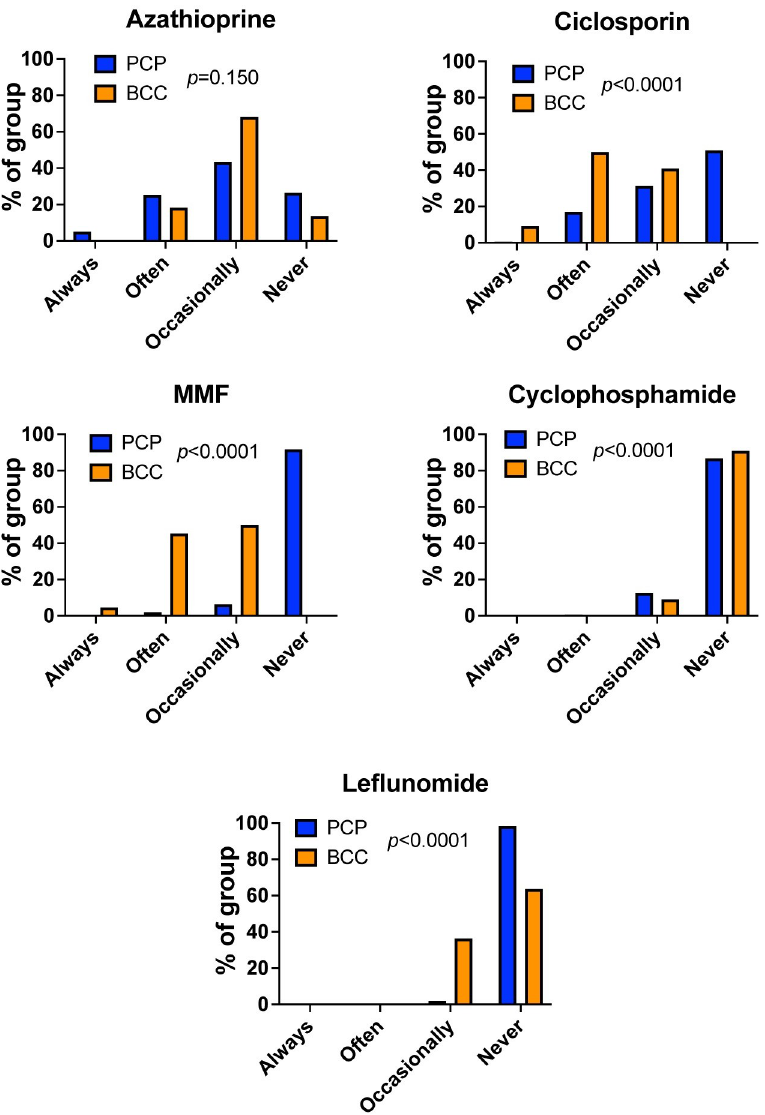
Fig 8. Primary care practitioners and board-certified clinicians use different combinations of immunosuppressive drugs in the clinic. Bar graphs showing the percentage of respondents using ( A ) azathioprine, ( B ) ciclosporin, ( C ) mycophenolate mofetil, MMF, ( D ) cyclophosphamide, or ( E ) leflunomide with indicated frequency according to group. PCP: primary care practitioner, n = 159. BCC: board-certified clinician, n = 22. Chi-squared or Fisher’s exact